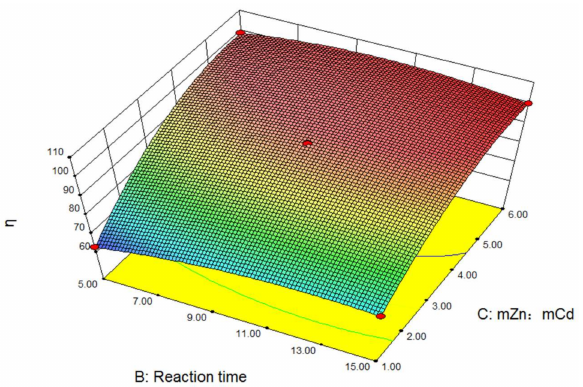
Figure 4. Influence of the reaction time and zinc dosage on the Cd removal